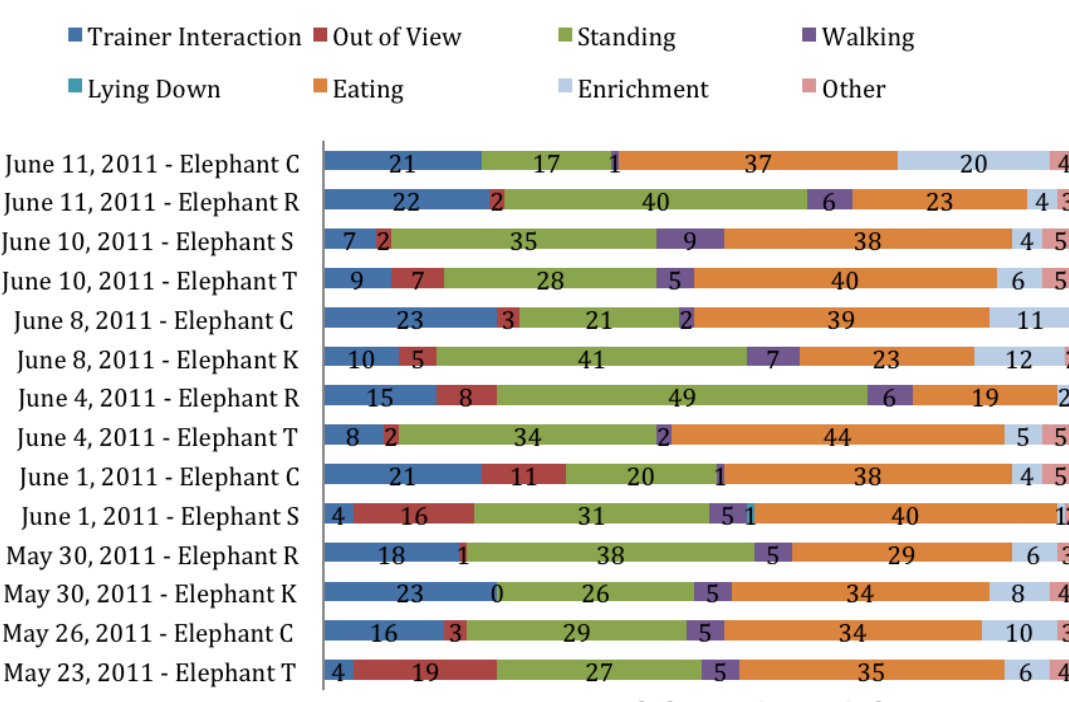
Figure 2. Diurnal activity time budgets for each elephant and observation period, shown as a stacked chart. All observation periods started at 6:30 and were 14 hrs long, except for June 1 st , which was 9 hrs long. Sunrise and sunset times for these dates in 2011: June 11, 06:33 – 20:26 hr. June 10, 06:33 – 20:25 hr. June 8, 06:33 – 20:25 hr. June 4: 06:33 – 20:23 hr. June 1: 06:34